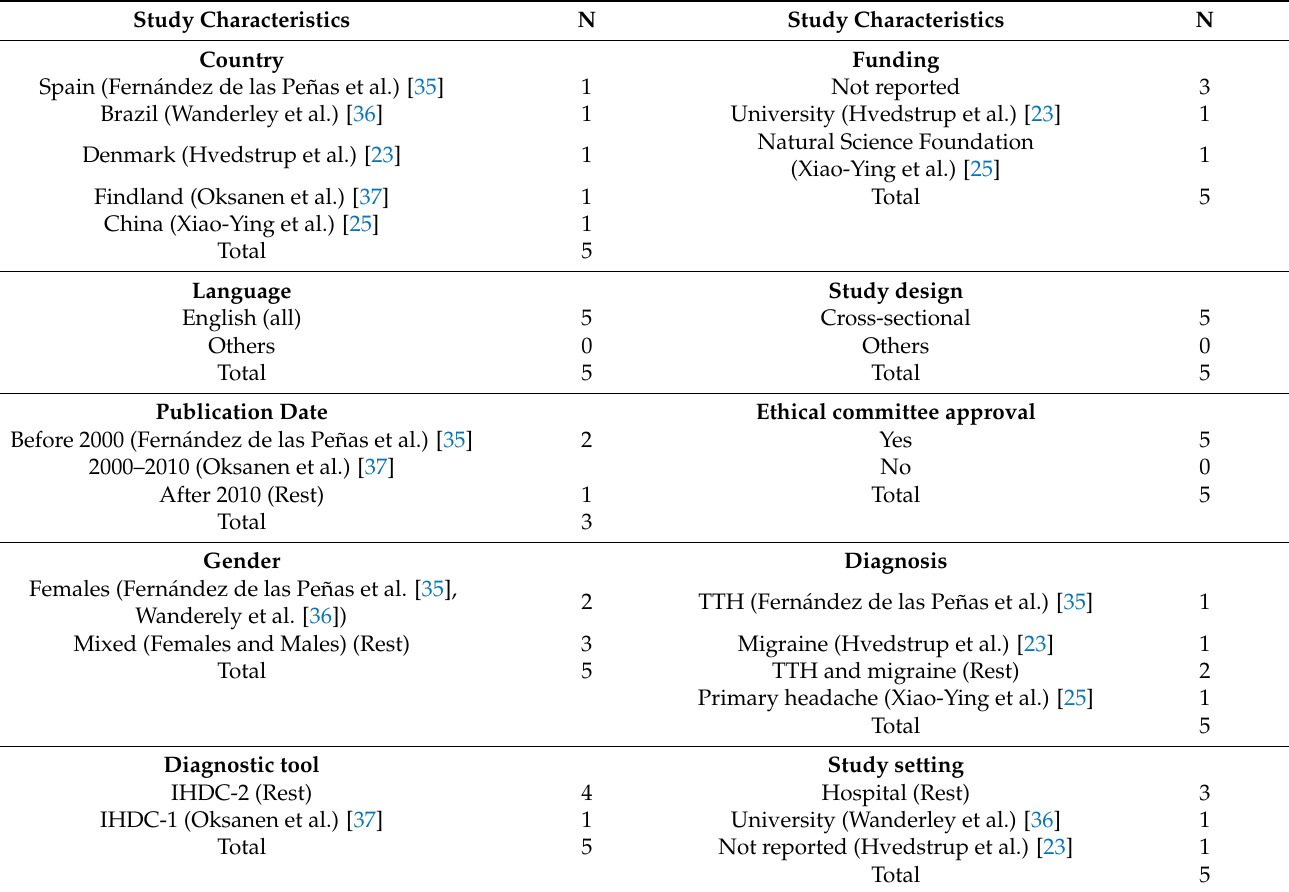
Table 1. General characteristics of the included studies. Authors: Fern á ndez de las Peñas et al.